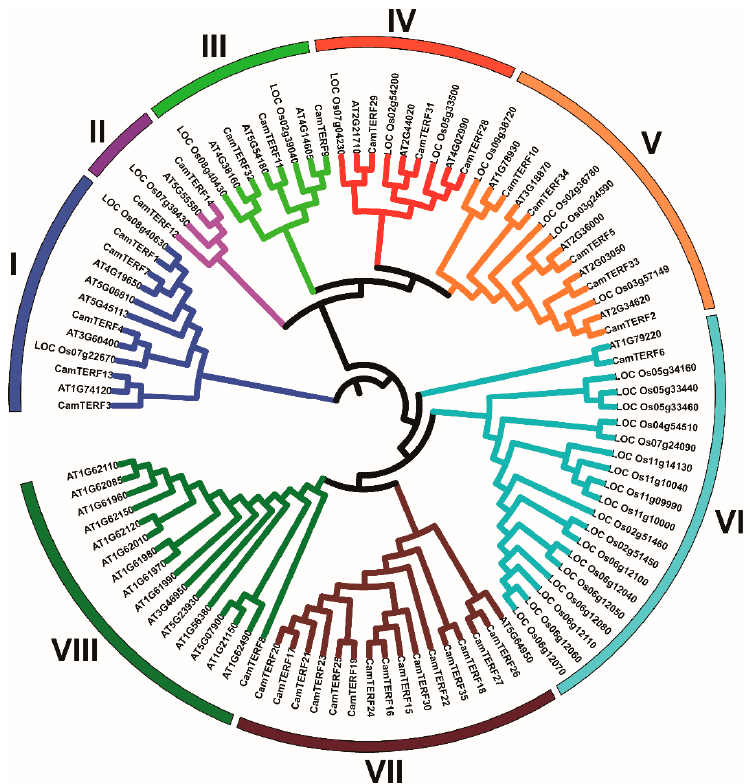
Figure 4. Phylogenetic tree of mTERFs from Arabidopsis , rice, and capsicum. The phylogenetic tree was constructed using the NJ (neighbor-joining) method with 1000 bootstrap replications. The eight subfamilies are distinguished with different colors.